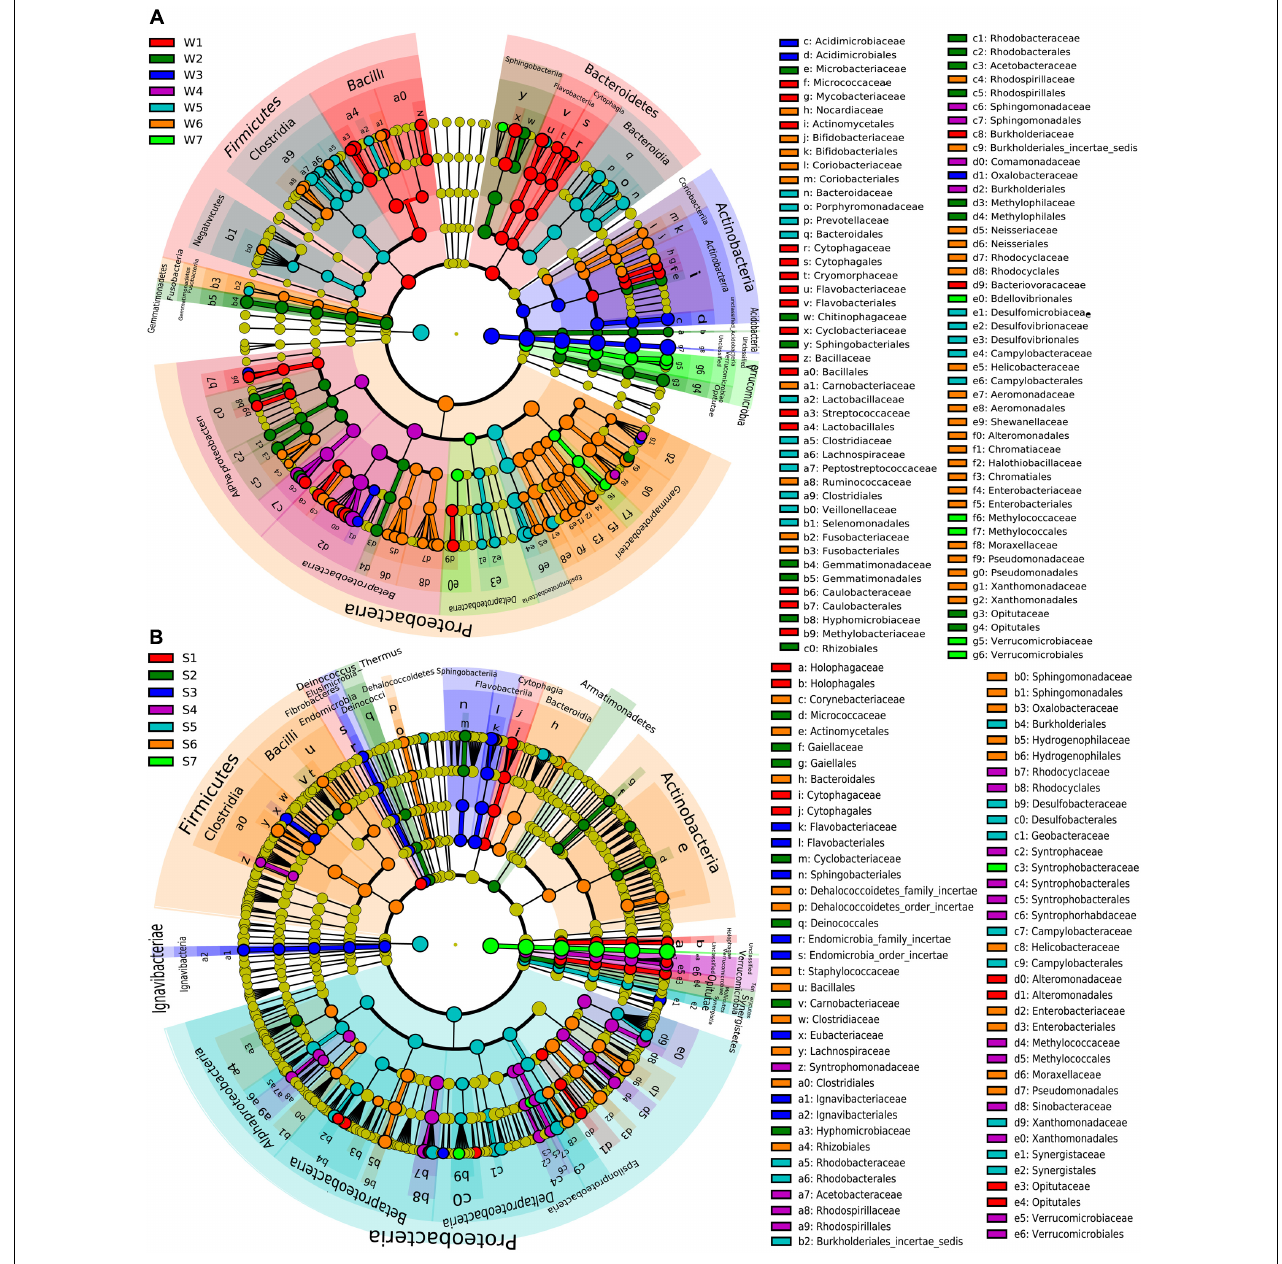
FIGURE 4 | LEfSe analysis of bacteria abundance among different water samples (A) or sediment samples (B) . The phylum, class, order, family levels are listed in order from inside to outside of the cladogram and the labels for levels of order and family are abbreviated by a single letter. The red, green, blue, purple, light blue, orange and emerald green circles represent the bacteria enriched in the site 1, 2, 3, 4, 5, 6, and 7, respectively, whereas the yellow circles represent the taxa with no significant differences between 7 sites of the water (A) or sediment (B)